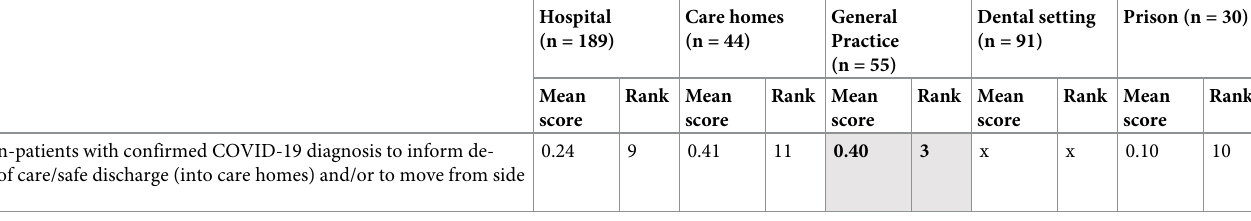
Table key: ‘PPE’ = ‘personal protective equipment’, x indicates use cases that were not proposed for that setting. The three most important use cases identified by the respondents in each setting are indicated in bold text and shaded cells. � Term ‘patient’ refers to residents and prisoners for care homes and prisons, respectively.